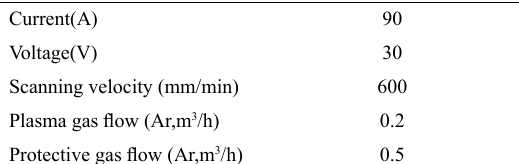
Figure 2. X-ray diffraction patterns of the composite